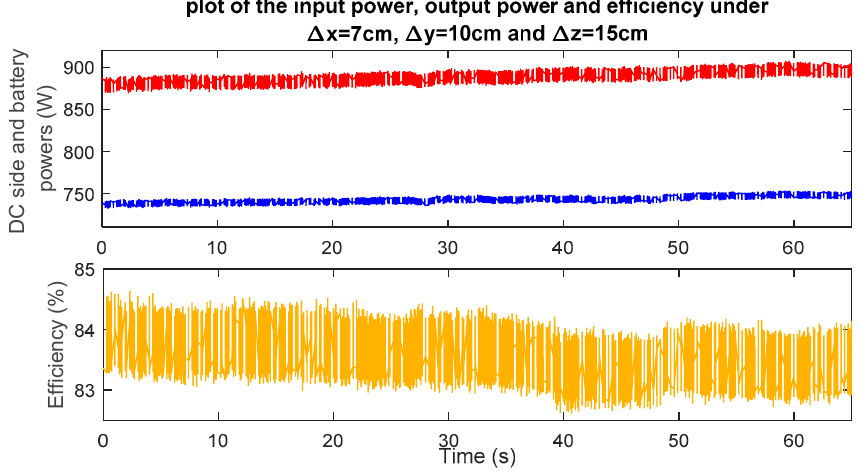
Figure 31. Variations of the DC-side power, battery power and efficiency in the presence of lateral misalignments (Vdc = 200 V, Δ x = 7 cm, Δ y = 10 cm and Δ z = 12 cm).